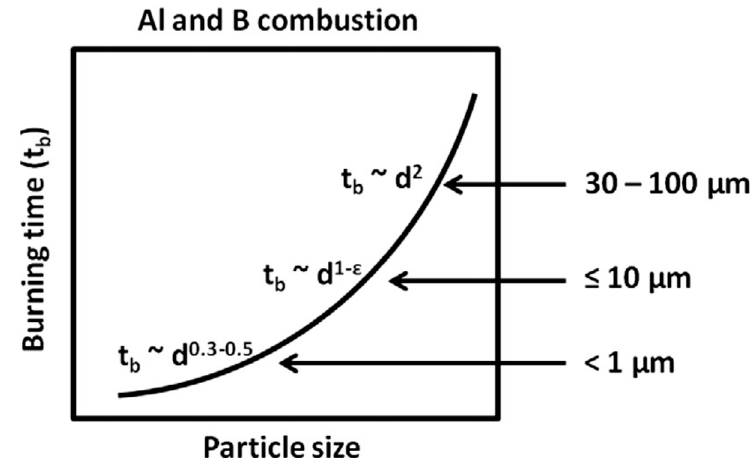
Figure 4. Conceptual figure showing determined experimentally for Al and B the burning time on size dependency. Reproduced from [13], with permission from Elsevier, 2014.